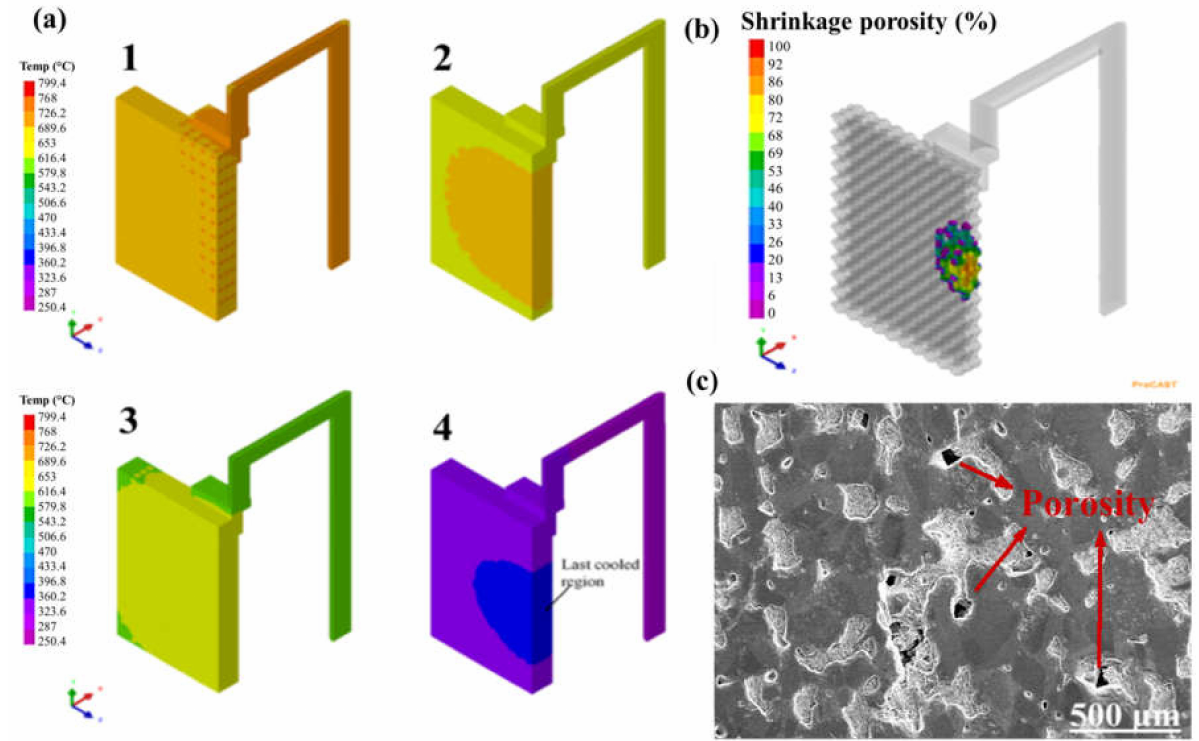
Figure 3. ( a ) The temperature distribution in the solidification process at (a-1) t = 28.4268 s, (a-2) t = 2012.5850 s, (a-3) t = 2809.8301 s, and (a-4) t = 9310 s. ( b ) The distribution of shrinkage porosity. ( c ) SEM micrograph of the center of the composite.